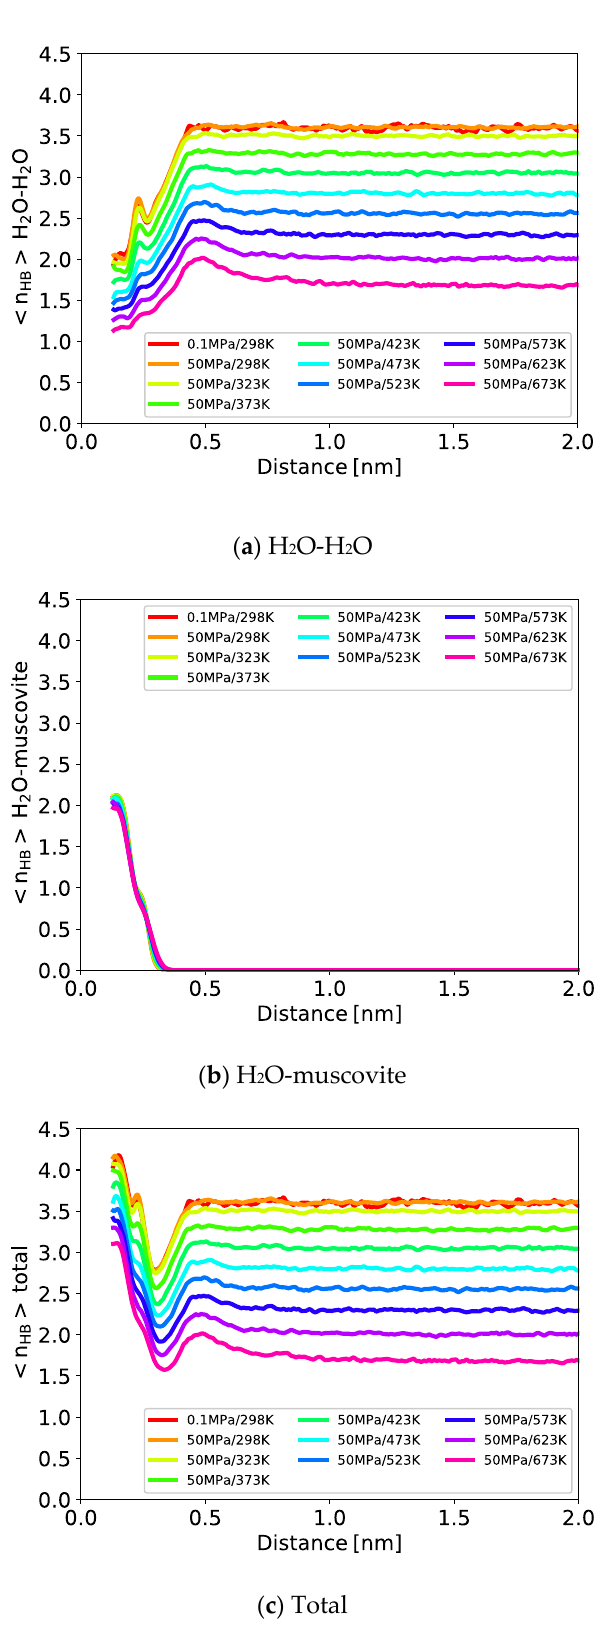
Figure 12. The number of hydrogen bonding per H 2 O molecule vs distance from muscovite sur- face.